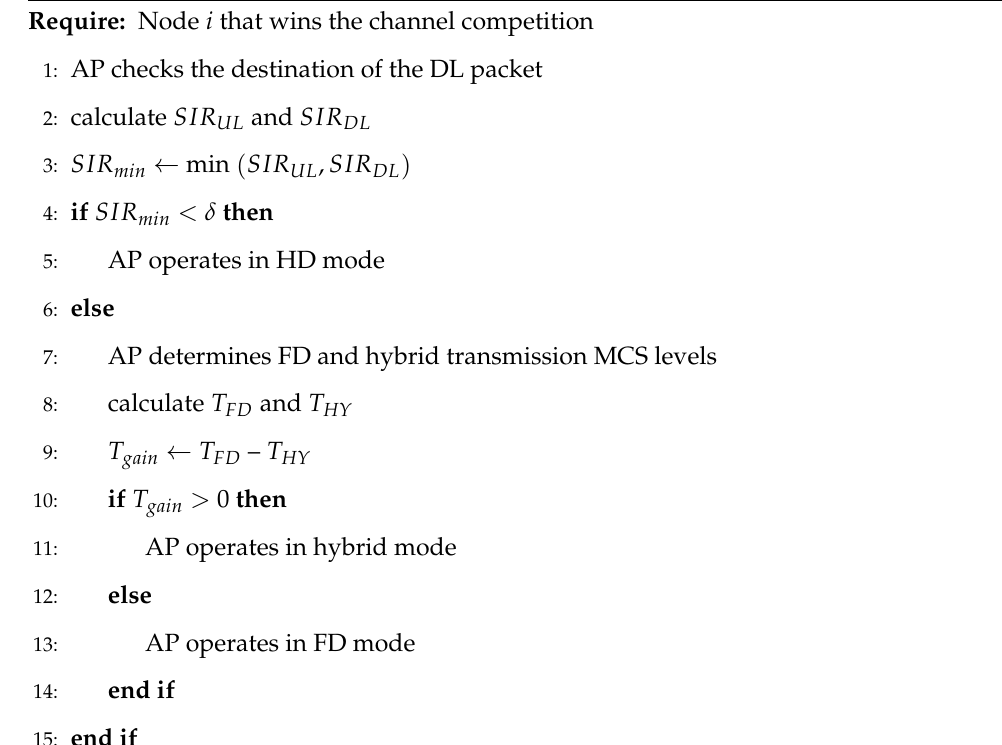
Algorithm 1 Hybrid transmission switching